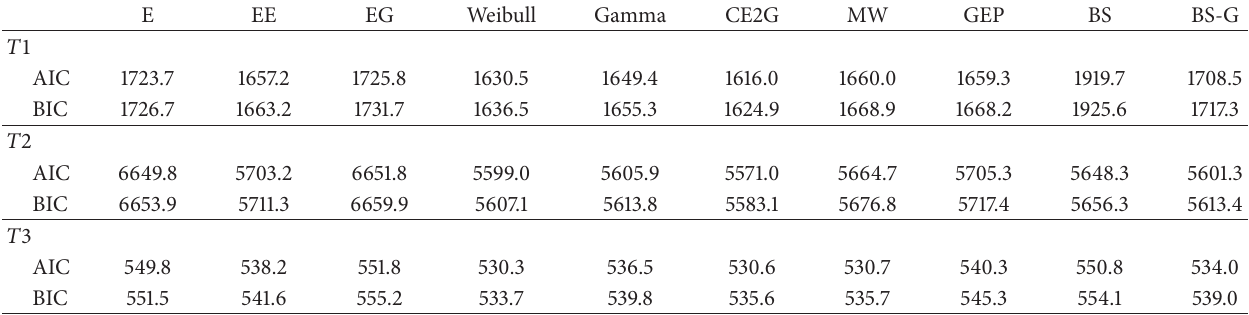
Table 2: Values of the—max ℓ(⋅) and AIC for all fitted